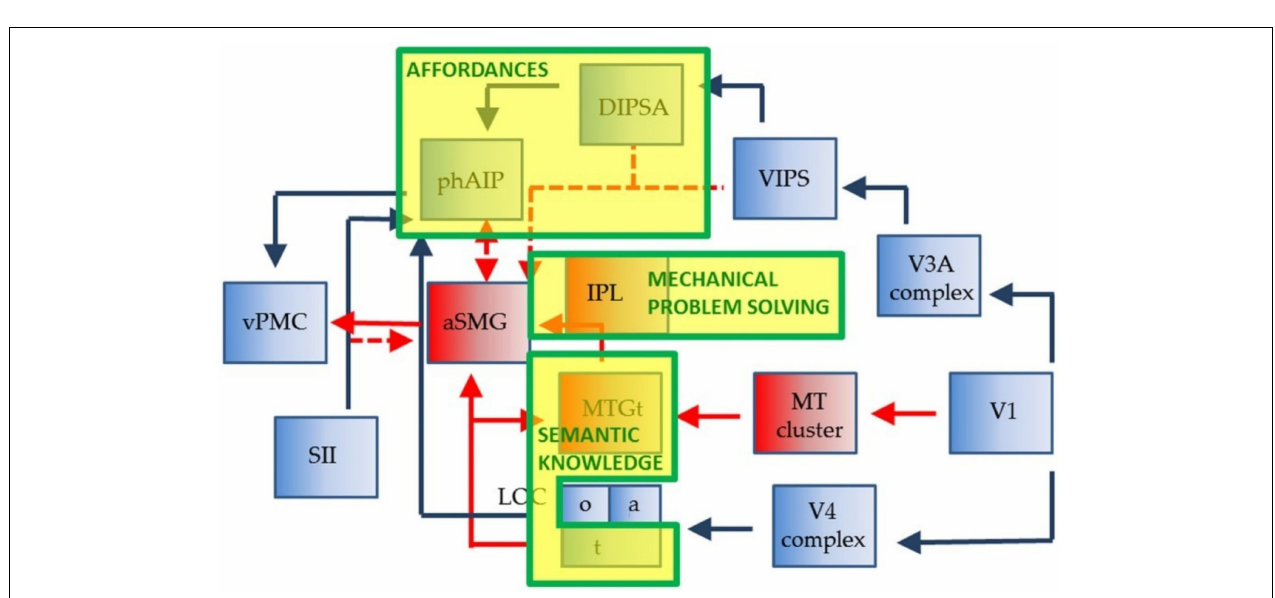
Frontiers in Psychology |